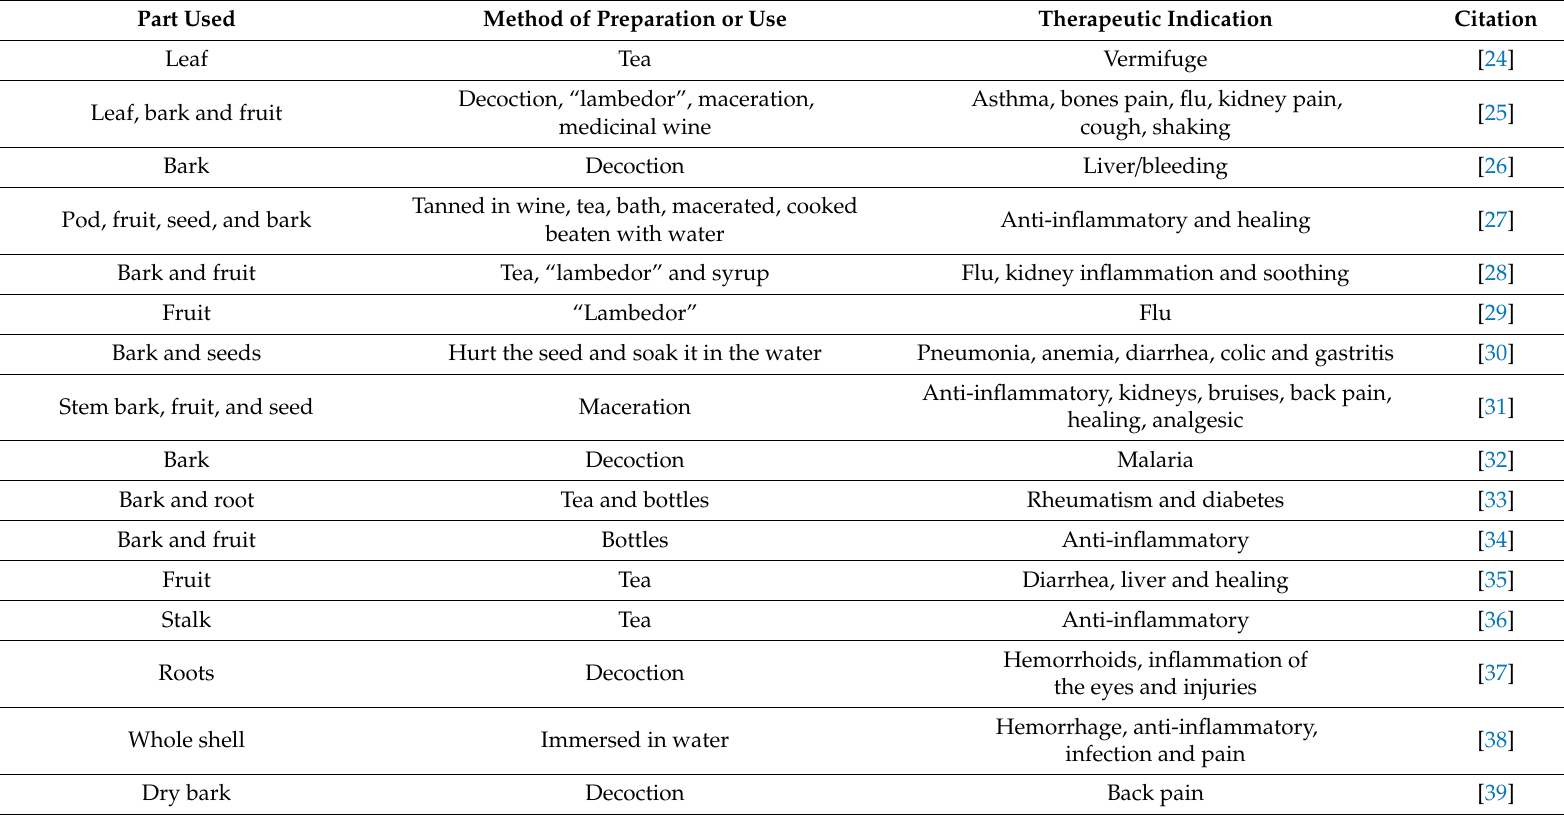
Table 2. Traditional uses of C. ferrea for curing